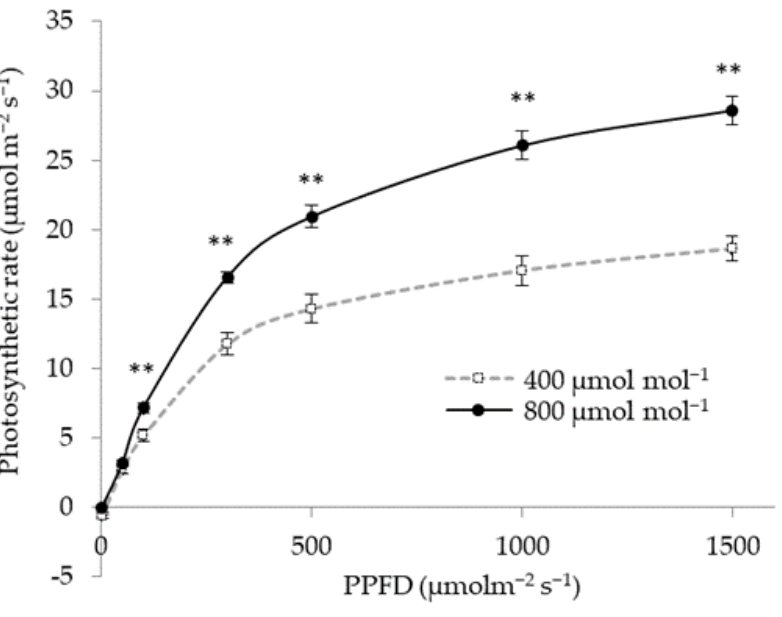
Figure 7. The relationship PPFD and photosynthetic rate of strawberry ‘Sagahonoka’. ** is significantly different at 1% level by t -test. Error bar means standard error ( n = 4). The measurement conditions are leaf temperature 20 °C, relative humidity 70%.